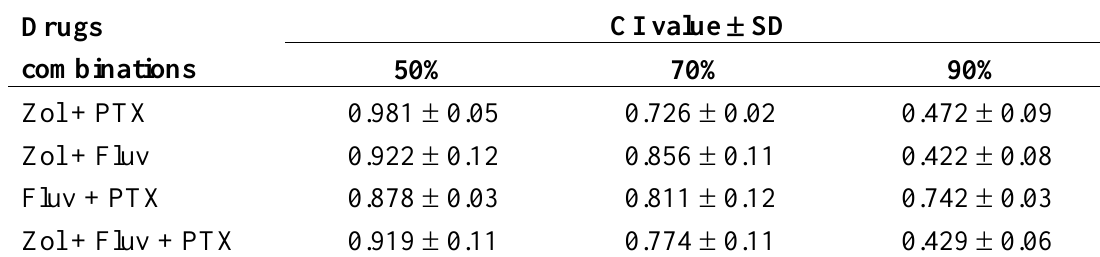
Table 1. CI values for the drugs combinations at 50, 70 and 90% growth inhibition of T24 cells. CI<0.9 represents synergy, CI values between 0.9 and 1.1 indicate additive activity, and CI>1.1 represents